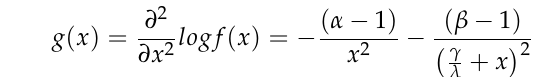
Figure 2. The relation between α and β , and the concavity of WD ( α , β , γ , λ ) . Example: The second derivative of the log of density is,